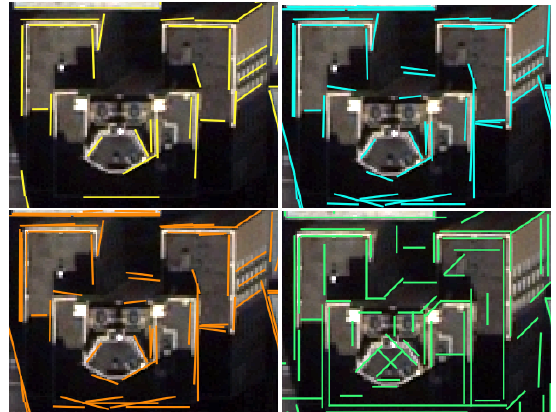
Figure 7. Edge detection in low contrast and shadowy areas. Top left are edges detected using LSD, top right are edges from EDLines. Bottom Left are edges obtained from Hough lines and bottom right is the edge detection framework